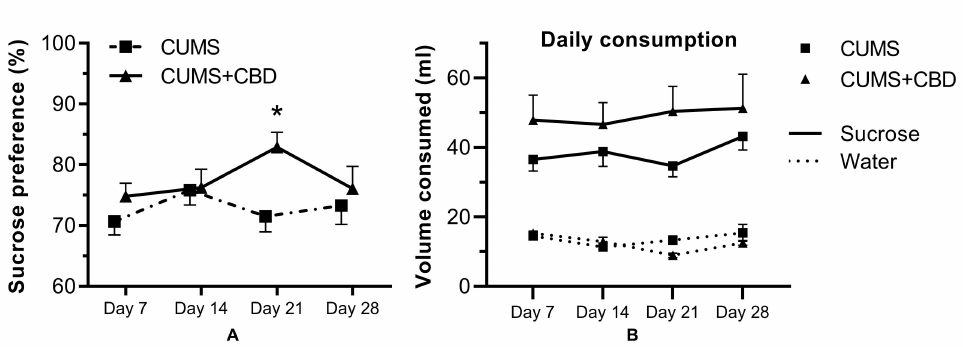
Figure 4. Results of the sucrose preference test for rats submitted to a four-week CUMS treatment with or without cannabidiol administration (mean ± SEM, n = 18). ( A. ) Sucrose preference measured as % preference for sucrose; ( B. ) sucrose (mL of 1.0% sucrose solution ingested) and water intake on each testing day. CBD, cannabidiol; * p < 0.05 vs